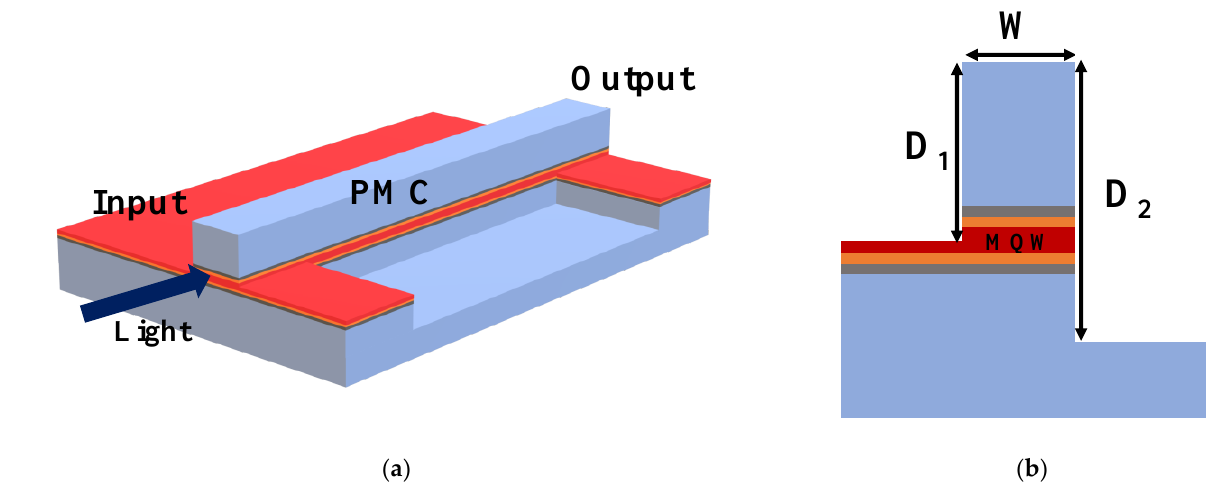
Figure 2. (a) Schematic of ha lf-ridge PMC with an AlGaInAs MQW layer, (b) cross section of the PMC. Figure 2. ( a ) Schematic of half-ridge PMC with an AlGaInAs MQW layer, ( b ) cross section of the PMC.